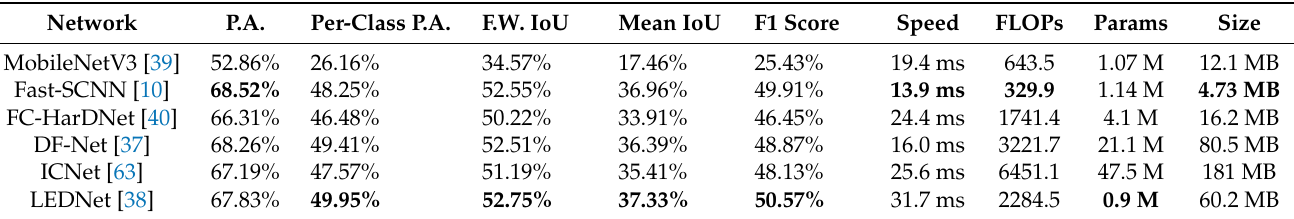
Table 2. Bold characters indicate the best performance. P.A. stands for Pixel Accuracy, F.W. for Frequency-Weighted and M for